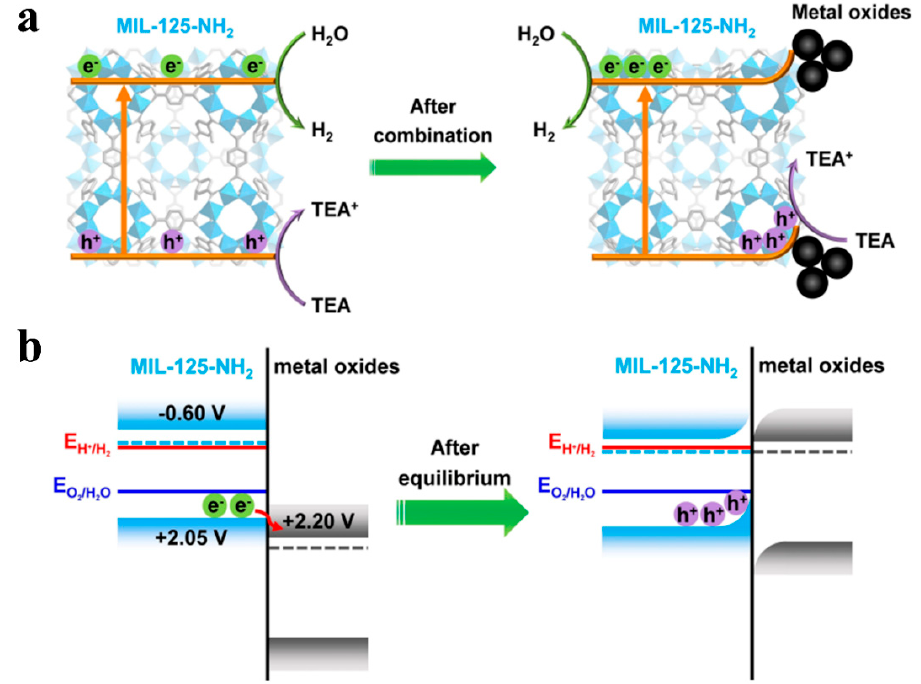
Figure 10. The schematic diagram of the photocatalytic hydrogen evolution for MIL-125-NH 2 (a) before and (b) after integration with the metal oxides. Reproduced with permission from Ref. [73].